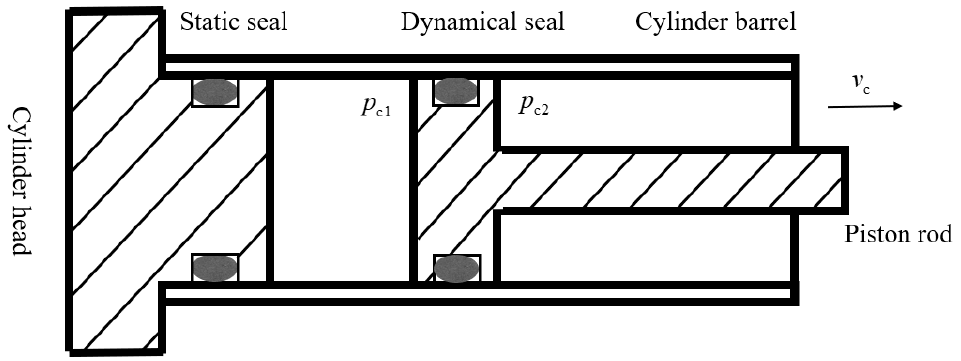
Figure 8. Schematic structure of cylinder.